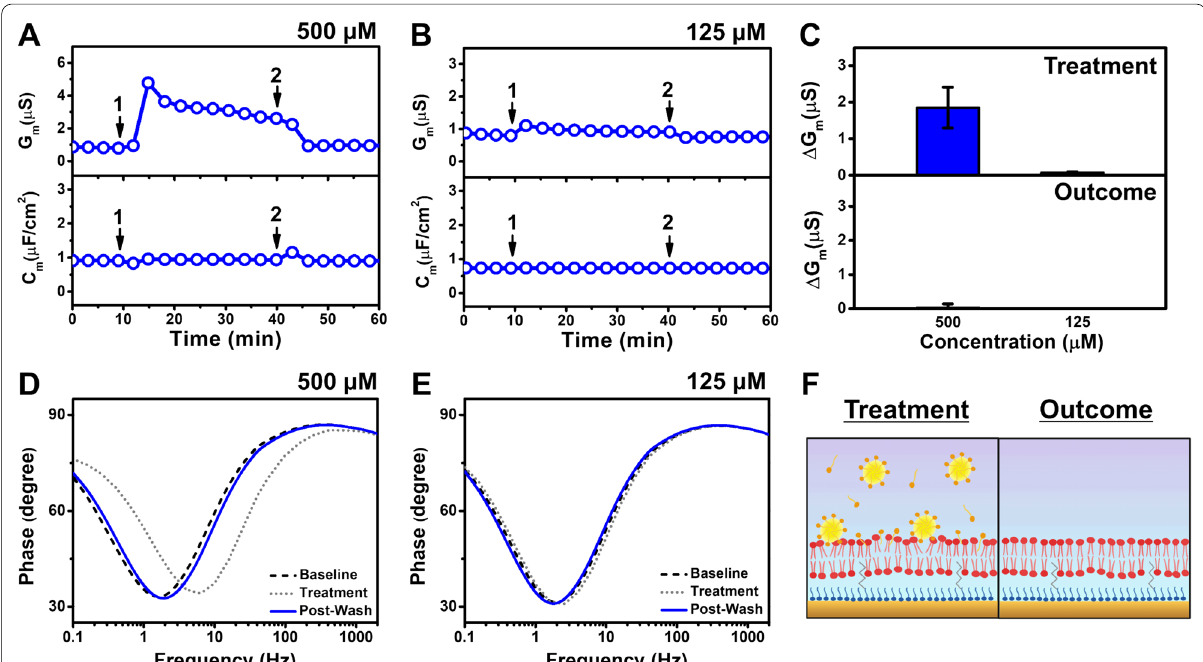
Fig. 6 EIS investigation of monoundecanoin addition to the tBLM platform. Time‑resolve changes in conductance (G m ) and capacitance (C m ) signals following the addition of ( A ) 500 µM and ( B ) 125 µM monoundecanoin to the tBLM platform. The initial baseline measurements correspond to standard values indicating formation of the tBLM platform in PBS solution on the gold electrode. After 10 min of establishing the baseline, monoundecanoin was added (arrow 1) and incubated for 30 min before buffer washing was performed (arrow 2). C Summary of G m shifts upon compound addition (top panel) and after buffer washing (bottom panel) relative to the tBLM baselines. Bode plots describing the phase shifts of the system from baseline signals in response to treatment with ( D ) 500 µM or ( E ) 125 µM monoundecanoin and buffer washing. F Schematic illustration based on the EIS data of how 500 µM monoundecanoin interacts with the tBLM and the resulting tBLM after monoundecanoin was removed by buffer